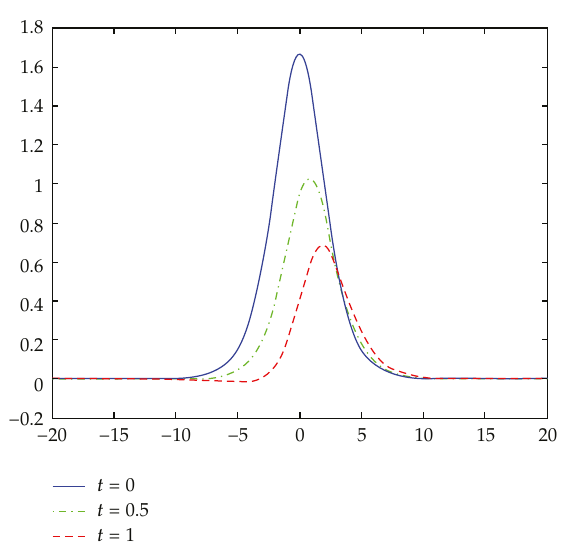
Figure 2: When τ (cid:7) h (cid:7) 0 . 05, the wave graph of ρ at various